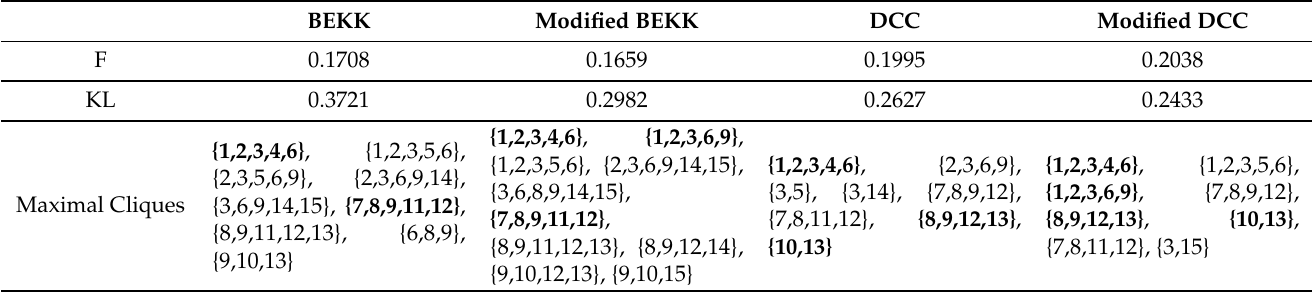
Table 8. Values of the Frobenius and Kullback–Leibler loss functions and the maximal cliques: case N = 15 and δ = 0.65. In bold the cliques of the simulated graphs that coincide to the ones of the original graph G ( δ )